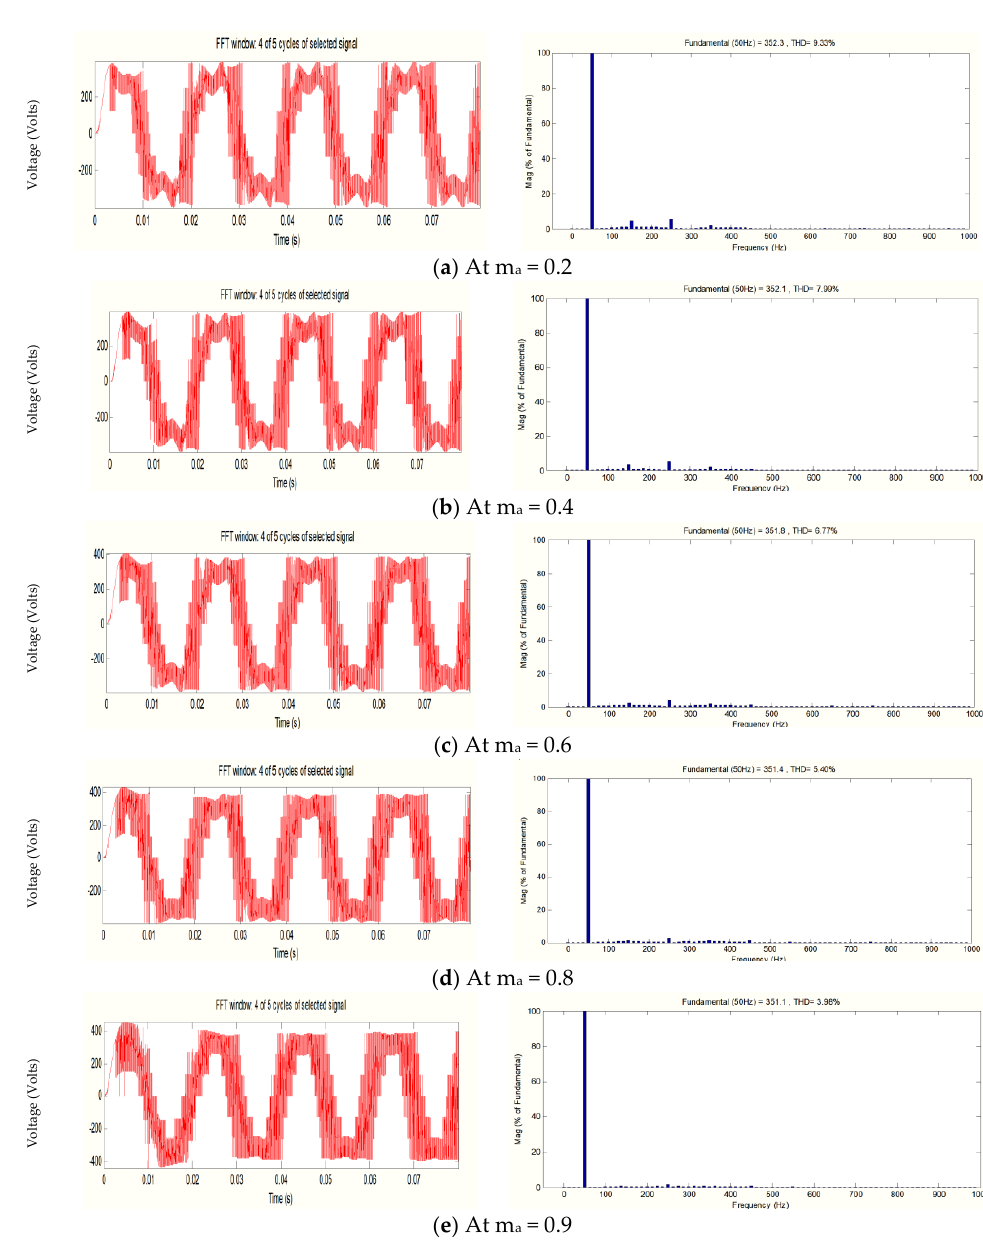
Figure 27. qZS-CHBMLI THD analysis.